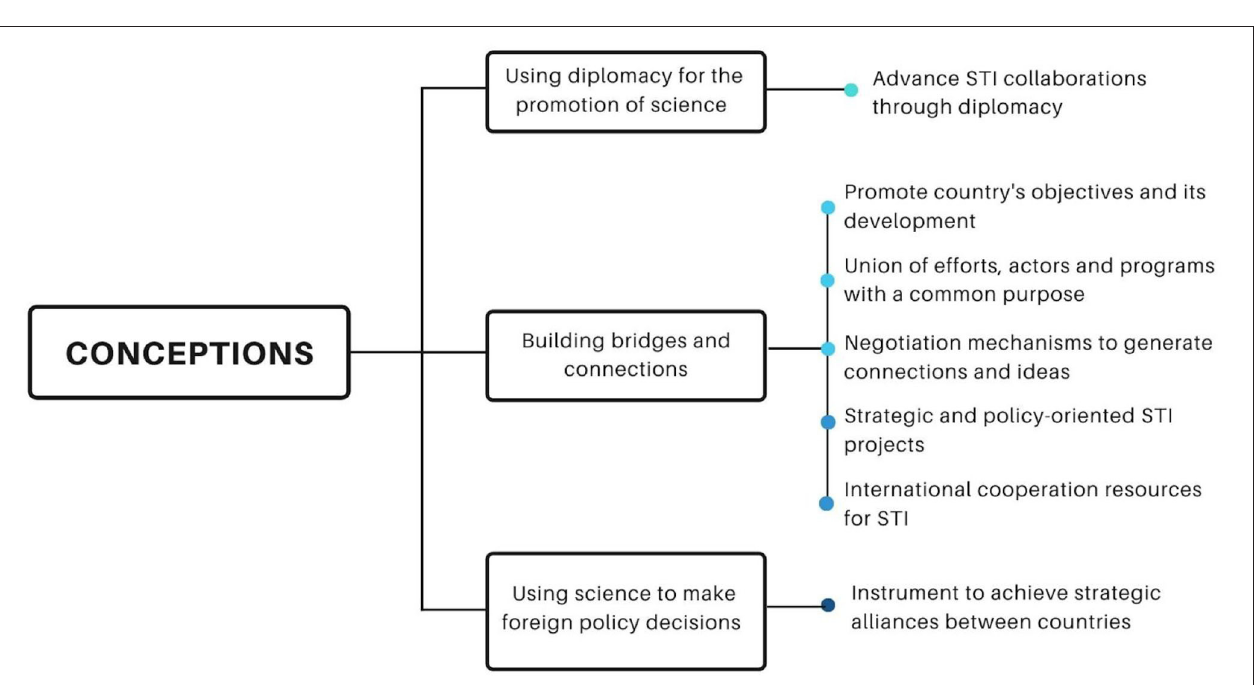
FIGURE 3 | Conceptions on SD. Participants were asked to define SD. Categories are developed by the authors based on frequency and similarity between the answers collected.